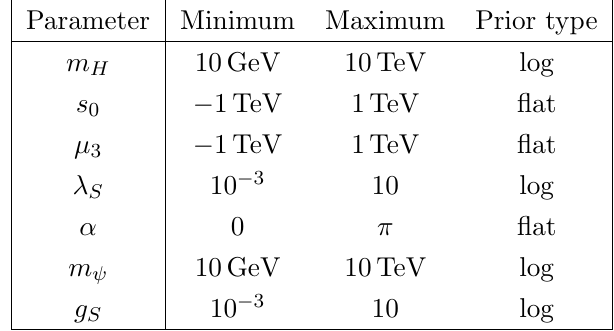
Table 1 . Ranges and priors for the free parameters of our model. All parameters are uniformly sampled over their ranges in either (cid:13)at or logarithmic space. For the mixing angle (cid:11) , all constraints are symmetric under (cid:11) (cid:11) , thus we only scan over (cid:11) [0 ; (cid:25) ! (cid:0) 2